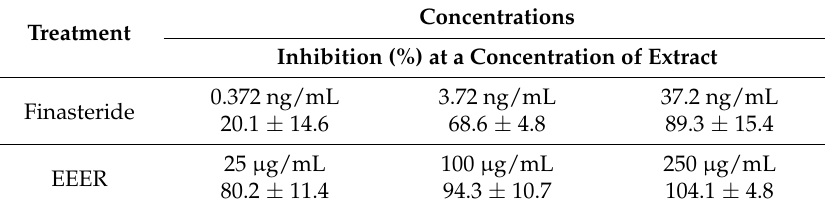
Table 1. Inhibitory effects of ethanol extract of E. rutaecarpa (EEER) and finasteride on rat prostate testosterone 5 α